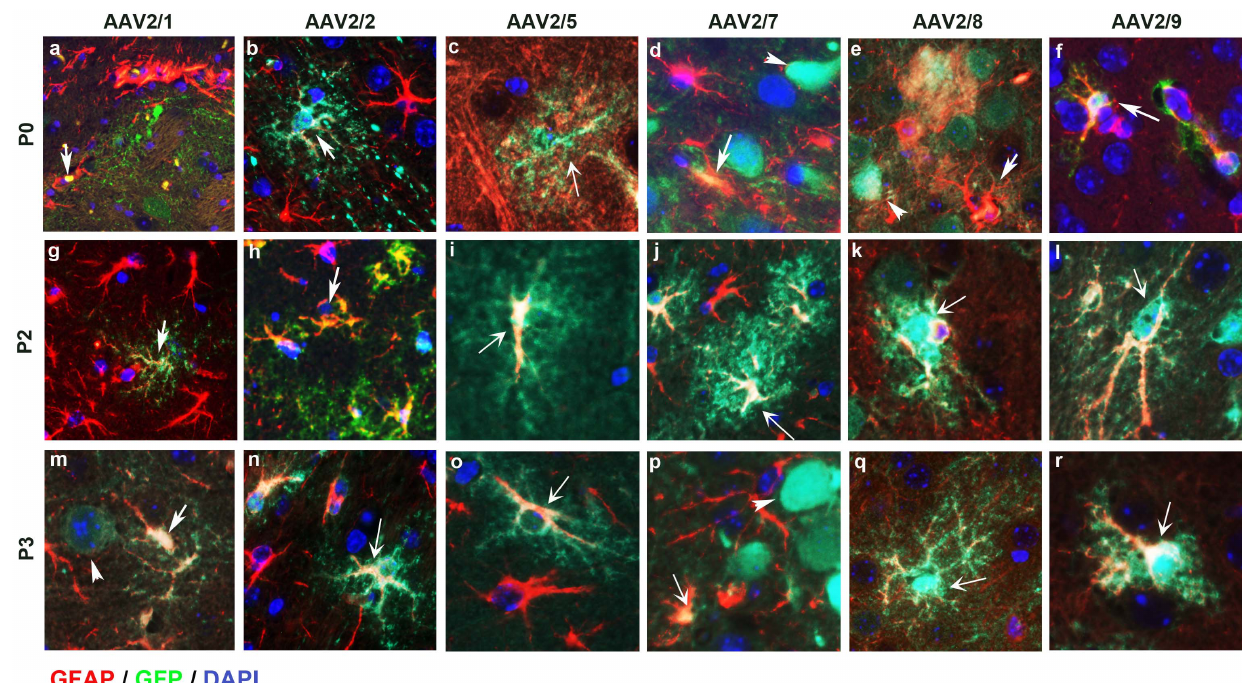
Figure 5. AAV2/n-EGFP tropism for astrocytes following intracerebroventricular delivery in neonatal mice. Representative tricolor merged fluorescent photomicrograph from 3 week old wild type mice injected on neonatal day P0, P2 or P3 with pseudotyped AAV2/n. Paraffin embedded brain sections were co-labeled with anti EGFP antibody (488 nm-green), anti GFAP-Cy5 (568 nm-red) and DAPI counterstain (blue). Images were scanned from the cortex of mice injected at P0 (a-f), P2 (g-l), P3 (m-r) with AAV2/1 (a,g,m), AAV2/2 (b,h,n), AAV2/5 (c,i,o), AAV2/7 (d,j,p), AAV2/8 (e,k,q) and AAV2/9 (f,l,r). Arrow, EGFP expressing astrocyte; arrowhead, EGFP expressing neuron. n=3–4/serotype/time of injection. Magnification 400x.